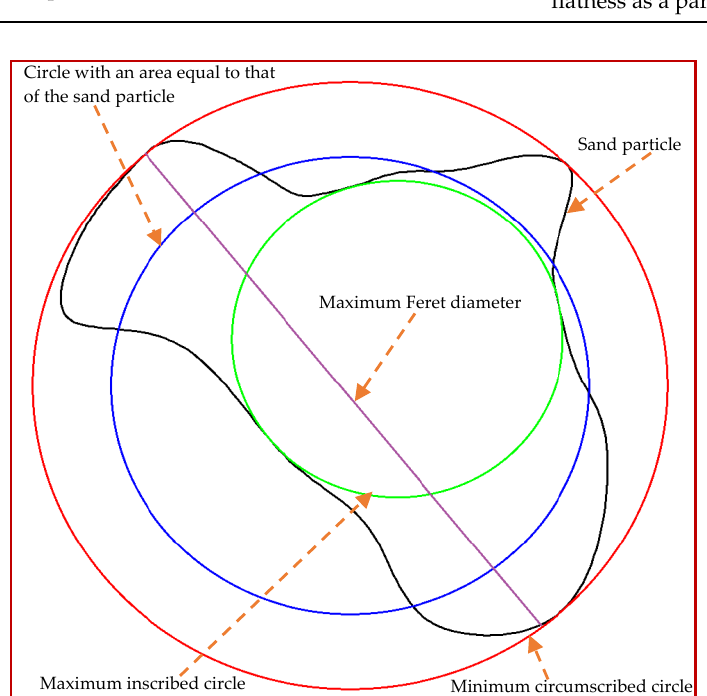
Figure 7. Schematic view of the basic size parameters of an irregular sand particle.